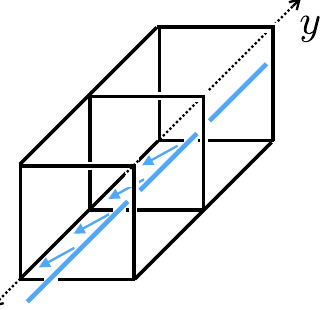
FIG. 14. The Walker-Wang part of the membrane operator that inserts a flux of X on a state that already has a flux of Z in a perpendicular direction. Naive successive application of the twist operators defined in the text leave a line of violated plaquettes at the intersection of the two fluxes. These are satisfied by running a semion string operator (blue line) through them. This blue semion string is glued into the lattice skeleton of our model using the local Walker-Wang graphical